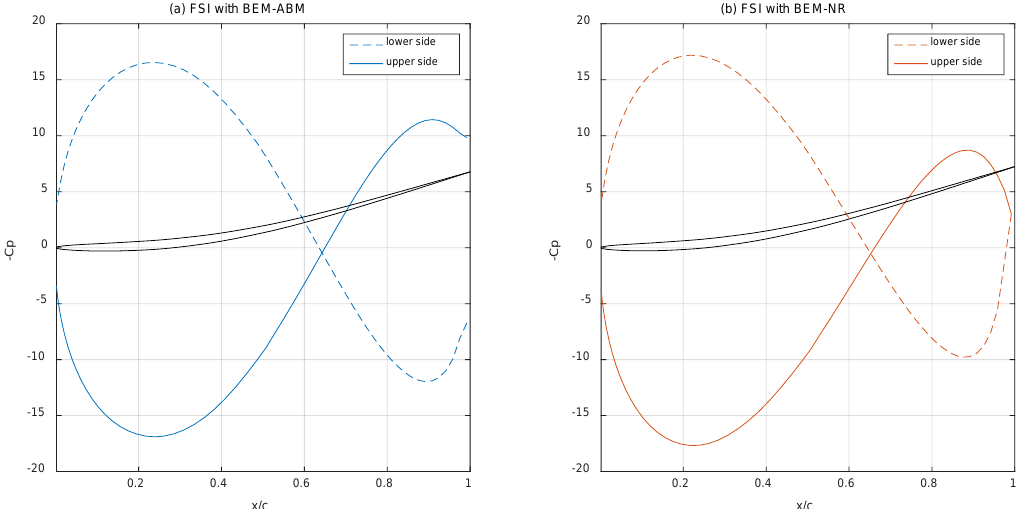
0.2 x/c Figure 12. Pressure coe ffi cient instantaneous distribution comparison between ( a ) BEM–ABM and ( b ) Figure 12. Pressure coefficient instantaneous distribution comparison between ( a ) BEM–ABM and BEM–NR, for the purely-heaving flexible plate with ω / ω = 3. The deformed foil deflection is added ω ω = The deformed foil deflection is ( b ) BEM–NR, for the purely-heaving flexible plate with / 3. for illustration ο added for illustration purposes.